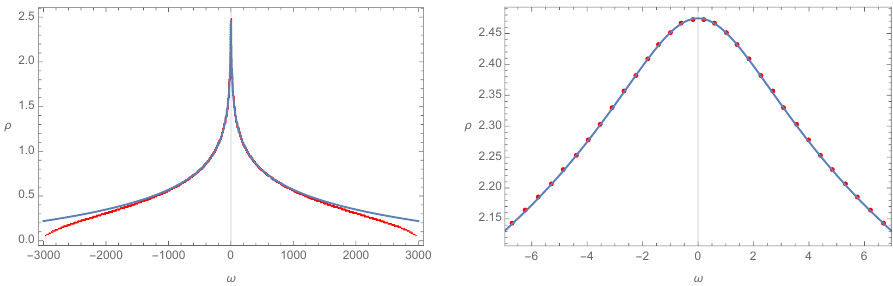
Figure 4. Density of states for a ∆ = 3 scalar in AdS 2 . The red dots show the coarse-grained density of states ¯ ρ ( ω ) , cf. (G.11), of the truncated model with global energy cut-off K = 2999 . K The blue lines show the character induced density of states ρ ( ω ) , cf. (G.9), with the UV cut-off Λ being e − γ E Λ ≈ 5981 . The plot on the left shows the two densities for the full spectrum of the truncated model while the plot on the right zooms in on the deep IR